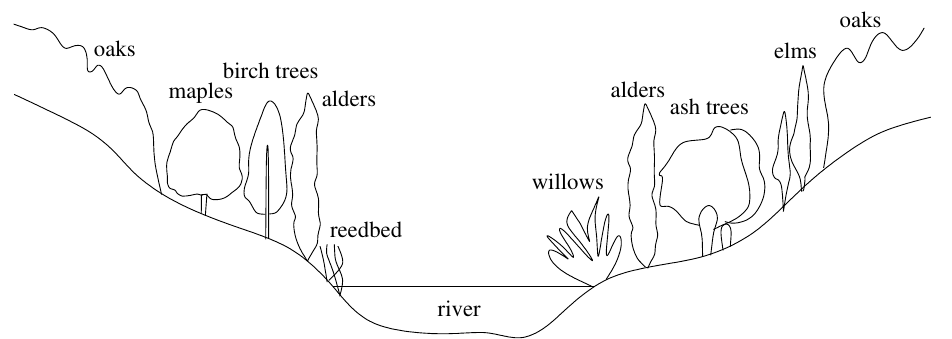
Figure 6. Cross section of a river basin showing riparian vegetation in Galicia.